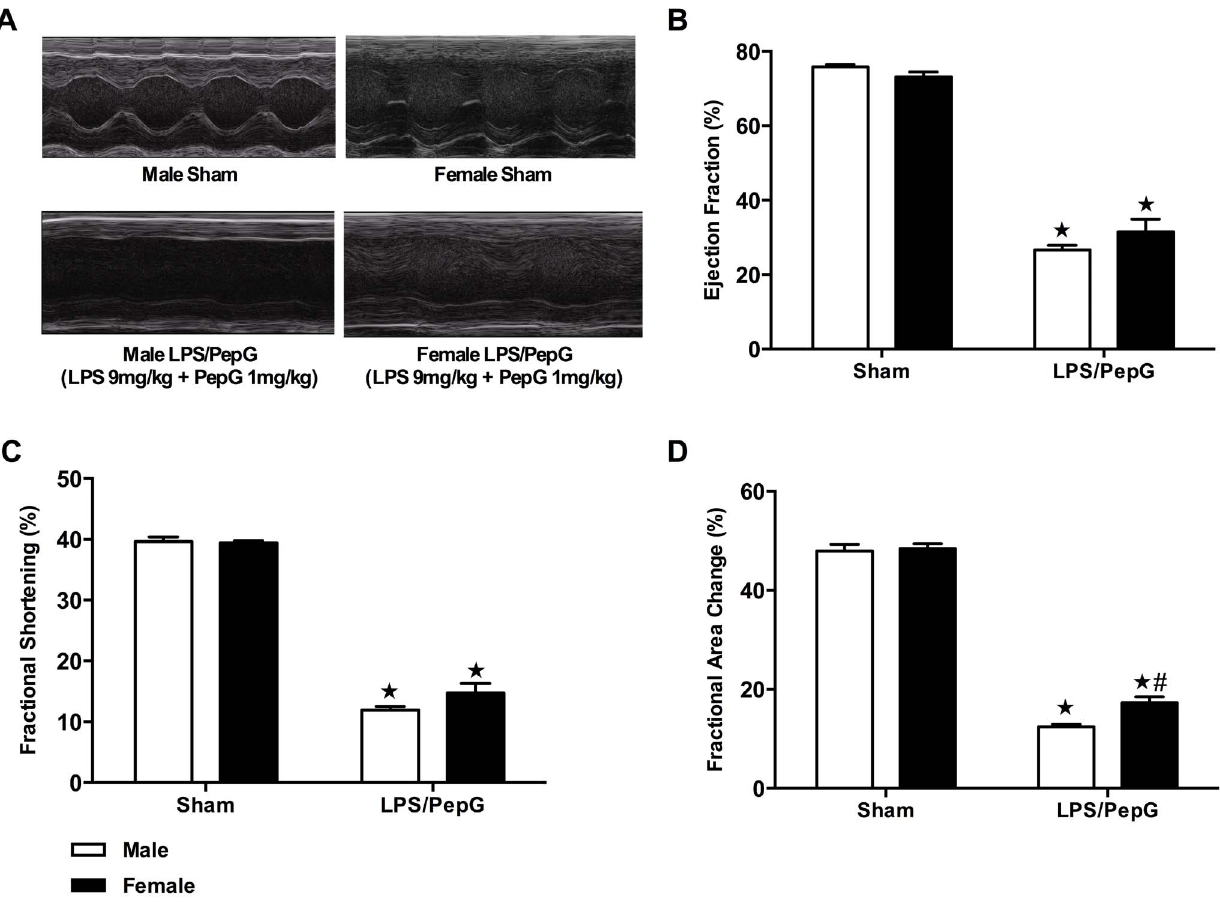
Figure 4. Gender dimorphism of cardiac dysfunction was blunted in response to high dose of LPS (9 mg/kg)/PepG (1 mg/kg) co- administration. Panel A – D : Male or female mice received either LPS (9 mg/kg)/PepG (1 mg/kg) or PBS intraperitoneally. Cardiac function was assessed at 18 hours. ( A ) Representative M-mode echocardiograms; percentage (%) ( B ) ejection fraction (EF); ( C ) fractional shortening (FS); and ( D ) fractional area of change (FAC). The following groups were studied: Male + vehicle (n=5); Female + vehicle (n=4); Male + LPS/PepG (n=11); Female + LPS/PepG (n=6). Data are expressed as means 6 SEM for n number of observations. w P , 0.05 versus the respective sham group, # P , 0.05 versus male LPS/PepG